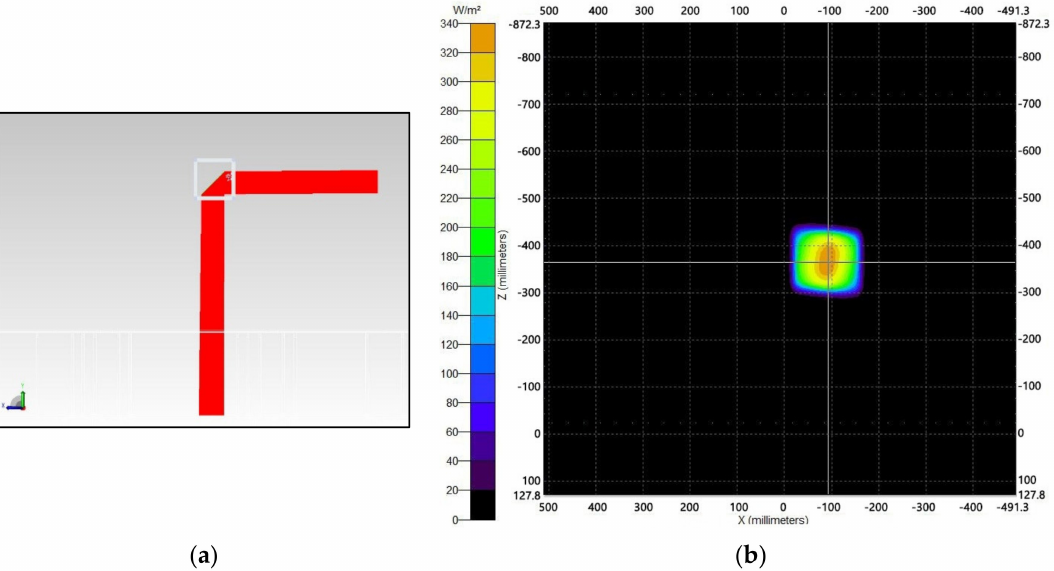
Figure 12. ( a ) Perspective view of optical path design with a flat mirror as the reflector; and ( b ) illu- minance map of the target plane reflected by a flat